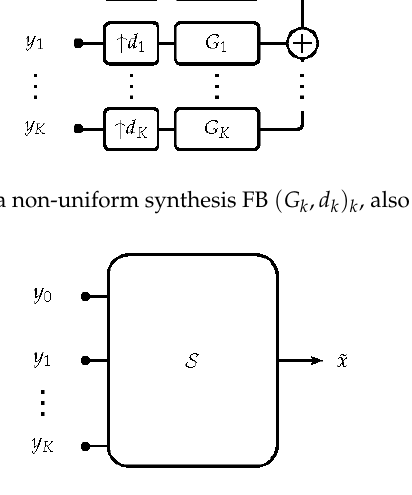
Figure 3. General structure of a synthesis system. S is a linear operator that maps the sub-band components y k to an output signal ˜ x